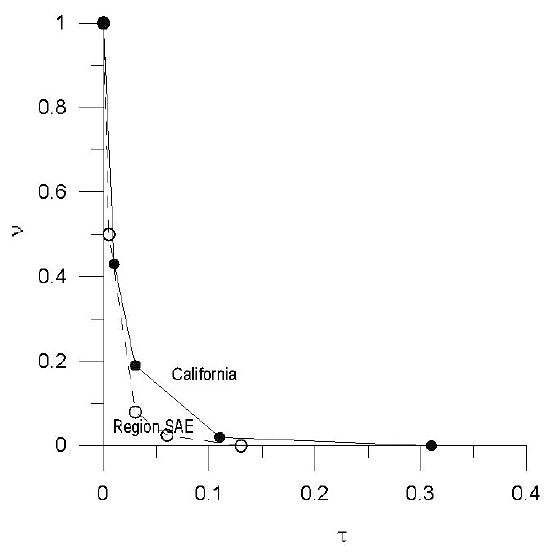
Figure 3. Empirical Molchan's diagram: the share of missed targets vs the share of alarms.